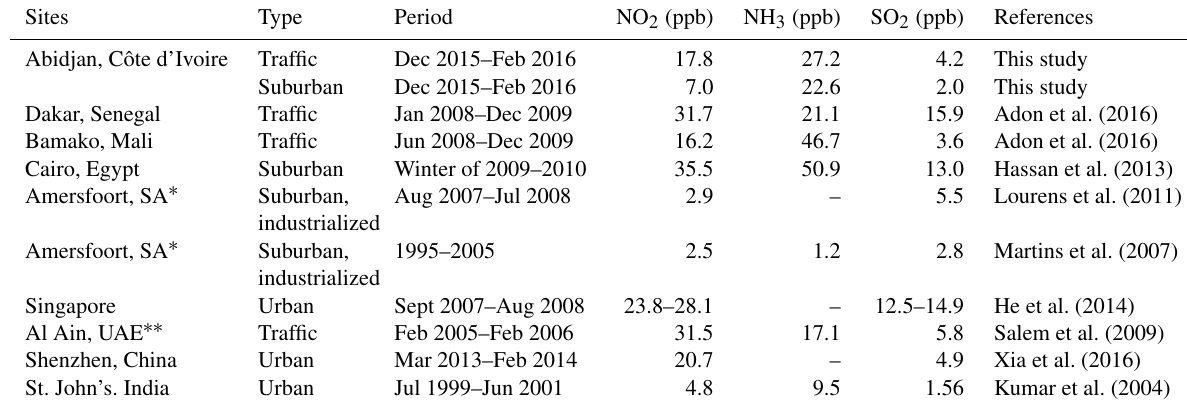
Table 5. Gaseous pollutants’ concentrations (ppb) at different sites of Abidjan and in other cities of developing countries. Sites Type